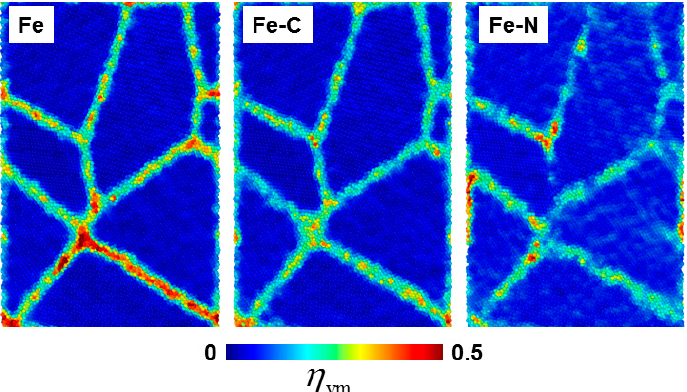
η ) obtained at 2% vm